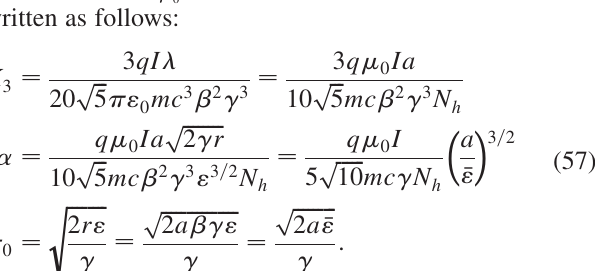
ffiffiffiffiffiffiffiffiffiffiffiffiffiffiffi p 2 a(cid:2)(cid:1)"